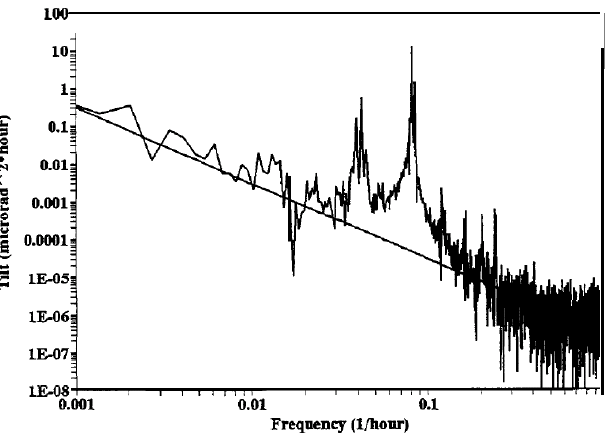
FIG. 29. A spectrum of ground motion in Sazare mine (Japan). The straight line indicates 1 =f 2 (from Ref. [40]).